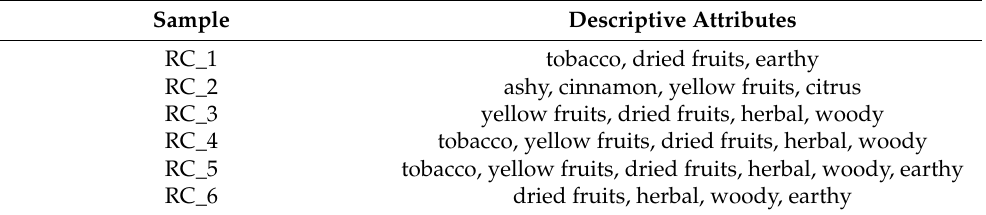
Table 7. Descriptive attributes of coffee brews.